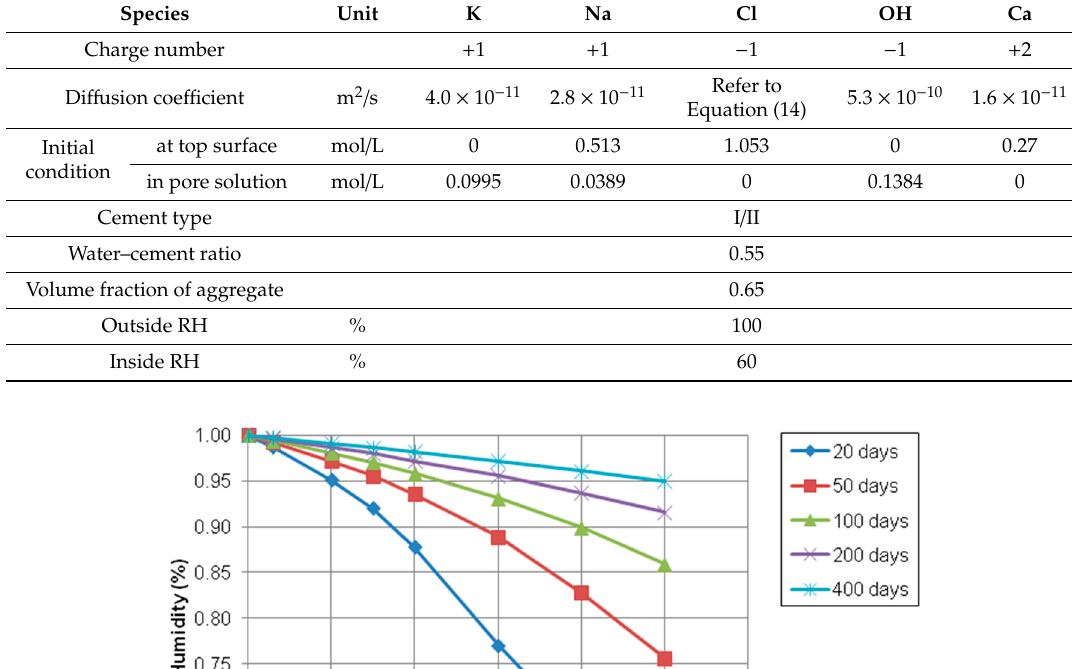
Table 2. Material parameters and input data for numerical analysis.